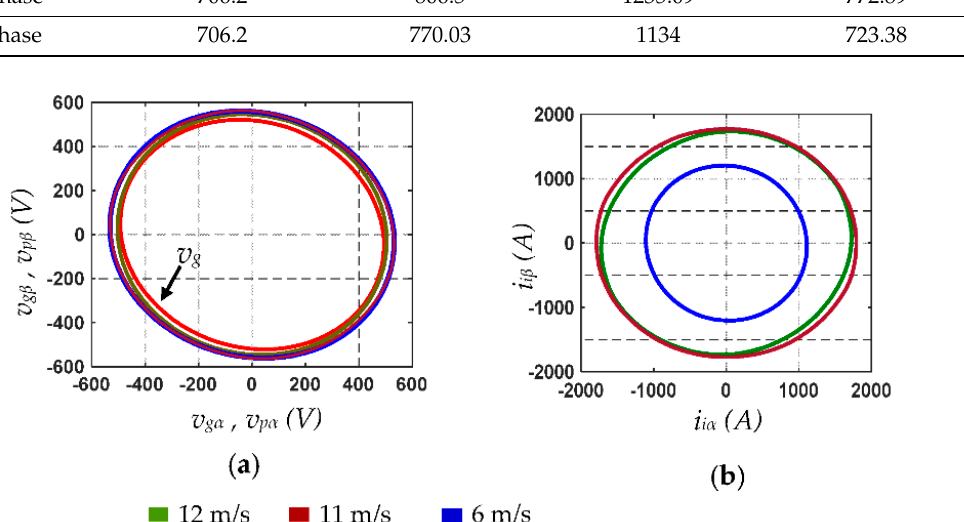
Figure 9. ( a ) grid and PCC voltage loci in the stationary reference frame, ( V ); ( b ) grid current loci in the stationary reference frame, ( A ).